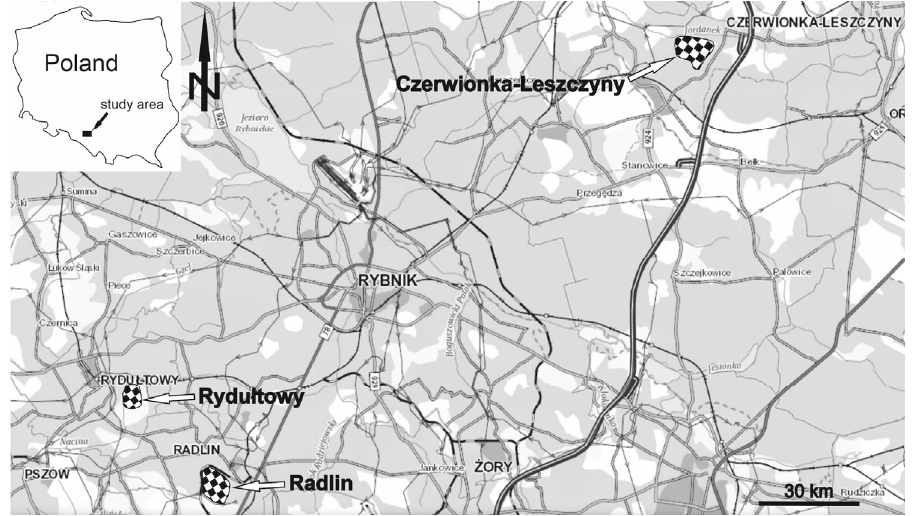
Figure 1. Location of the studied burning coal-dumps of Upper Silesia in the Rybnik region. Powder X-ray diffraction (PXRD) and scanning electron microscope (SEM) with energy dispersive spectroscopy (EDS) attachment were used to identify minerals. The presence of all minerals was confirmed by PXRD using a powder X-ray diffractometer X’Pert PRO MPD (Almelo, The Netherlands). The parameters of the X-ray beam were as follows: CoK α wavelength, emitted from the X-ray tube with 40 mA and 40 kV current applied. X-ray patterns were recorded in the 2.5 ◦ to 75.99 ◦ 2 θ range, with a step size of 0.02 ◦ . The results were processed using the X-ray analysis software X’Pert Plus HighScore (ver. 2.2e)